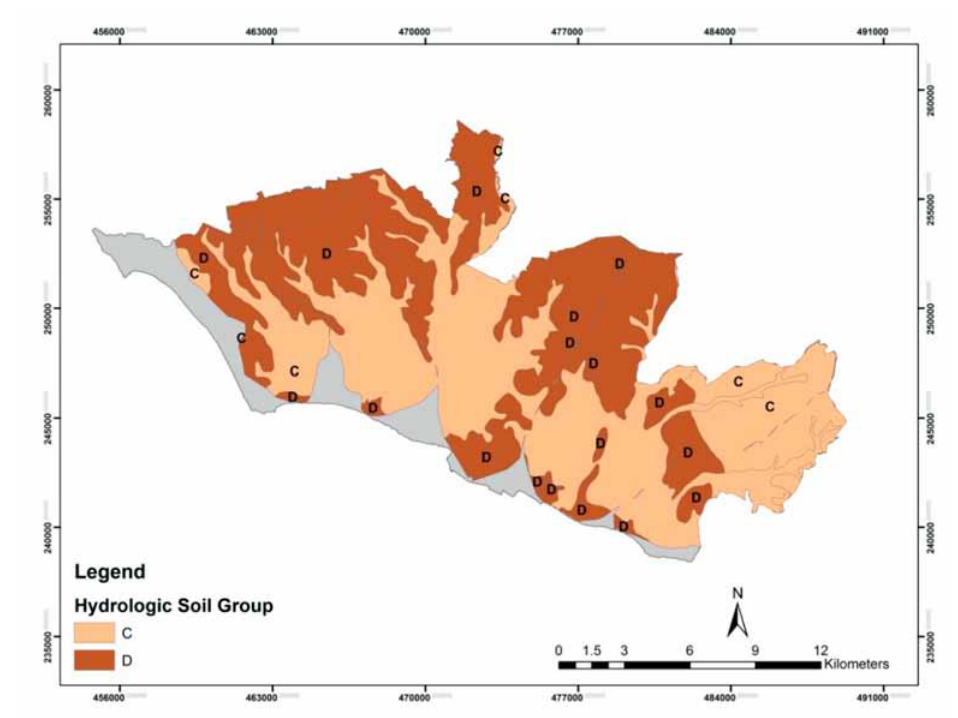
Fig. 3. Hydrologic soil group map of Melaka Tengah